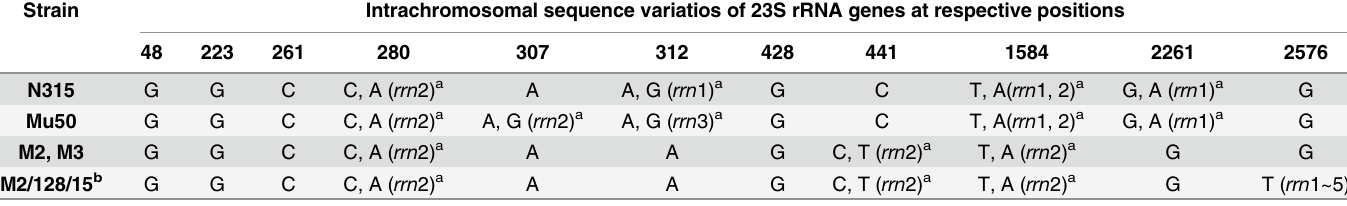
Table 4. Intrachromosomal variations of 23S rRNA genes.